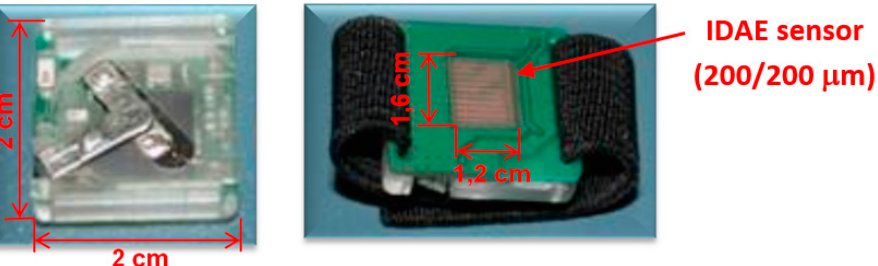
Figure 8. Electrodermal activity (EDA) Holter.